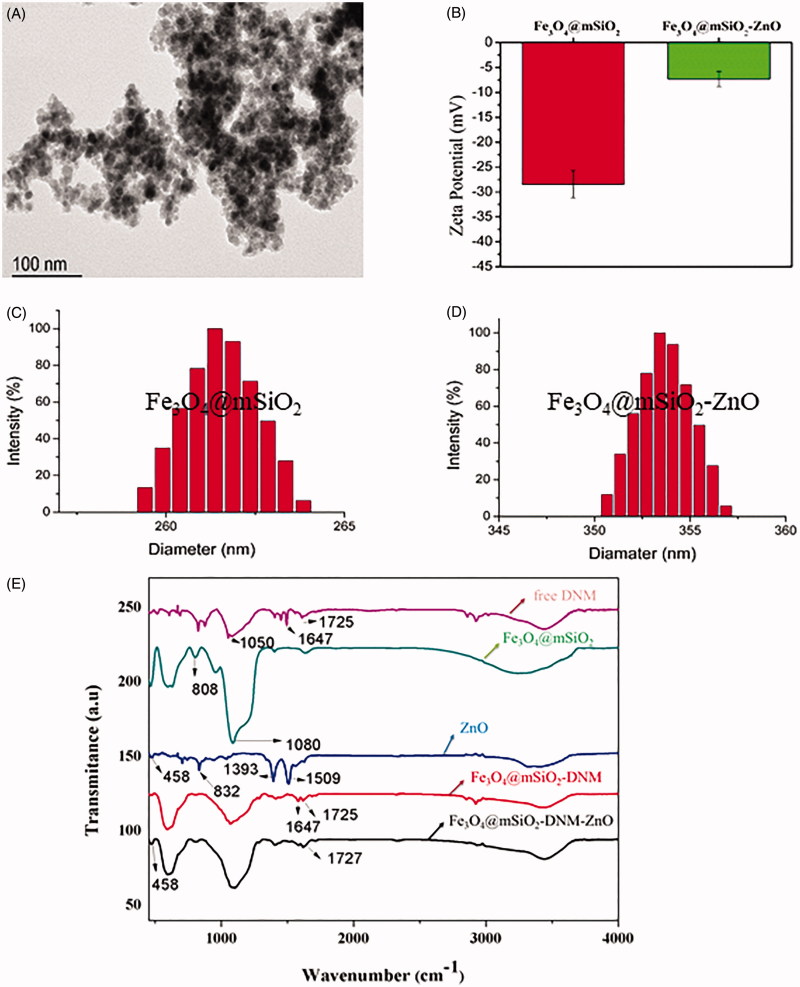
TEM image of (A) Fe3O4@mSiO2-DNM-ZnO NPs and (B) zeta potentials of Fe3O4@mSiO2 and Fe3O4@mSiO2-ZnO nanoparticles and the size distribution of (C) Fe3O4@mSiO and (D) Fe3O4@mSiO2-ZnO nanoparticles, and (E) FTIR spectra of free DNM, Fe3O4@mSiO2, ZnO, Fe3O4@mSiO2-DNM and Fe3O4@mSiO2-DNM-ZnO.